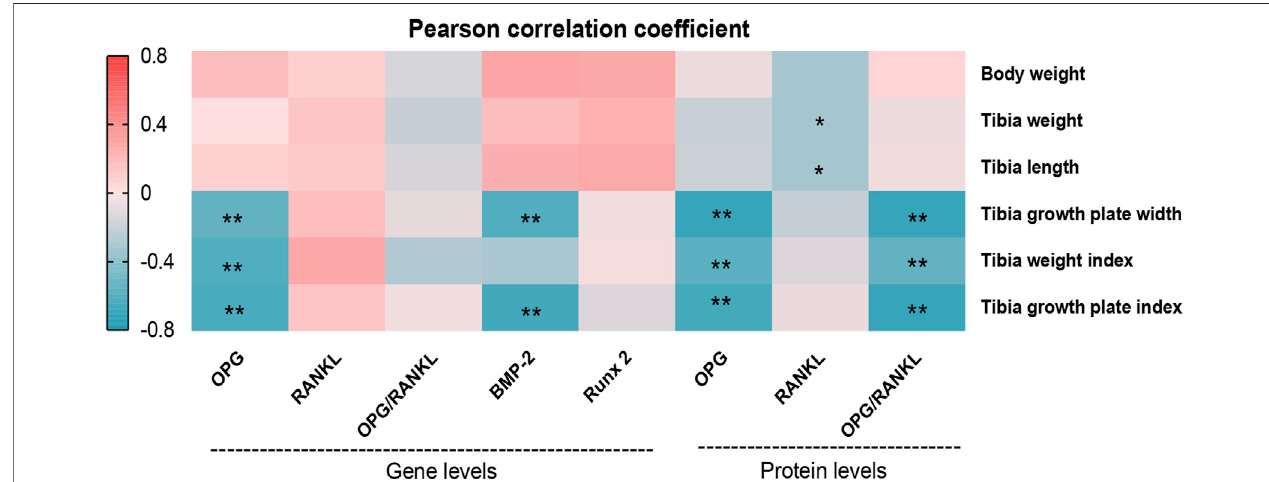
FIGURE 6 | Correlation heat map analysis of tibial growth parameters and osteogenesis-related biological indicators in broilers. Note: The different rectangles are colored based on the Pearson correlation coef fi cients between tibia growth performance expression levels and bone formation-related indices. The intensity of color represents the degree of correlation, red represents positive correlation, blue represents negative correlation. *indicates signi fi cant correlation ( p < 0.05), ***indicates highly signi fi cant correlation ( p < 0.001).